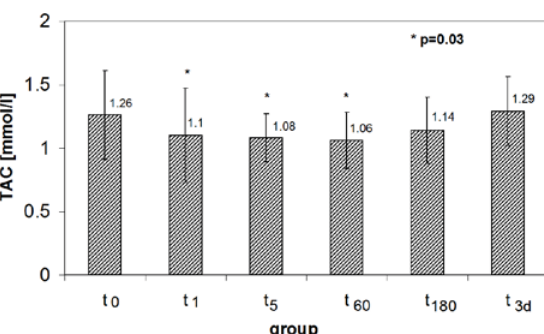
and after PCI (t , 1 min after PCI; t , 5 min after PCI; t 1 5 h after PCI; t , 3 h after PCI). *p = 0.03 for AMI group t 180 vs. groups t , t , and t 1 5 60